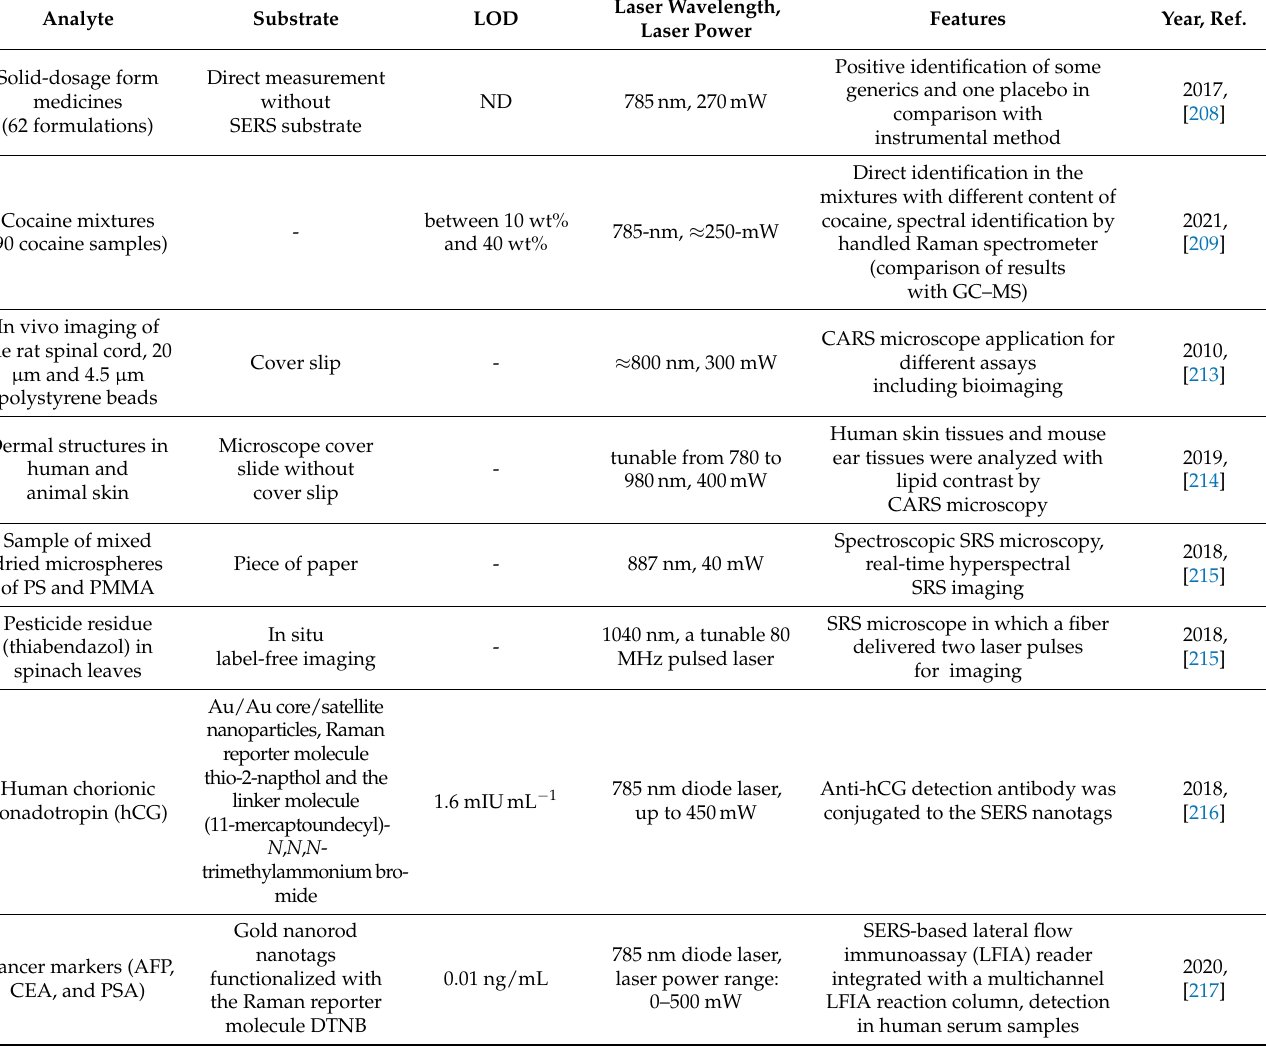
Table 4. Raman detection using portable